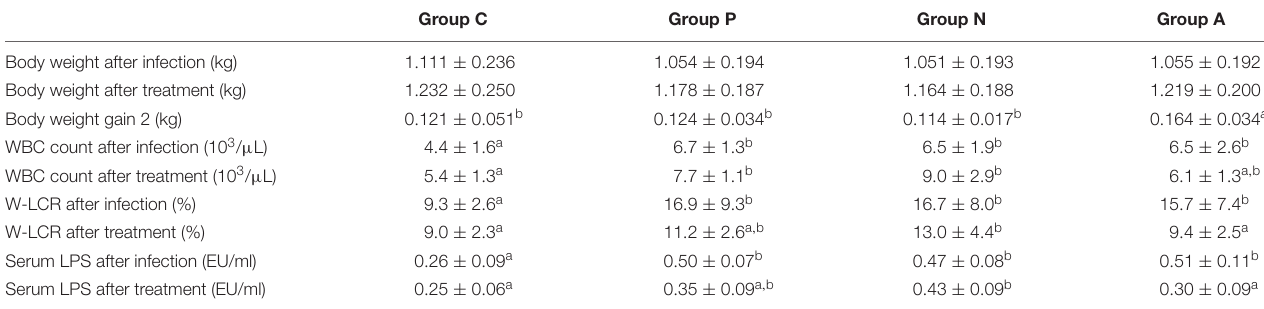
TABLE 2 | Body weight, body weight gain, WBC count, W-LCR and serum LPS concentration of rabbits with different treatments (Mean ±